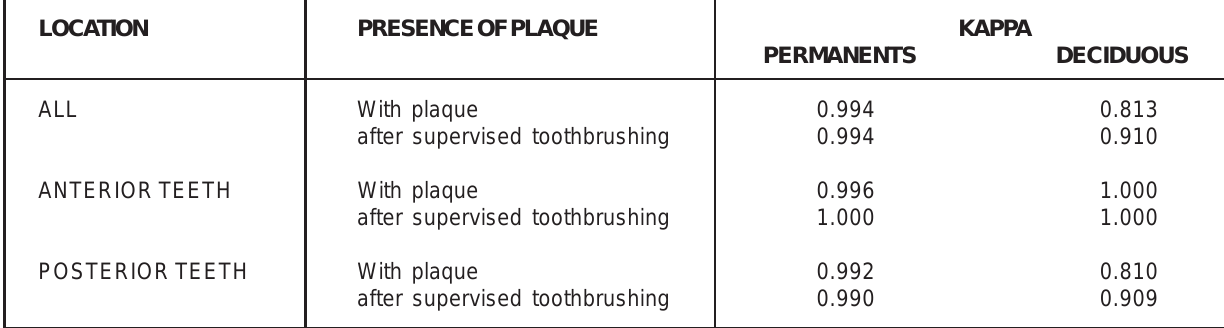
FIGURE 2- Reproducibility indicator (Kappa) for permanent and deciduous teeth according to the presence of bacterial plaque and location in relation to the “gold